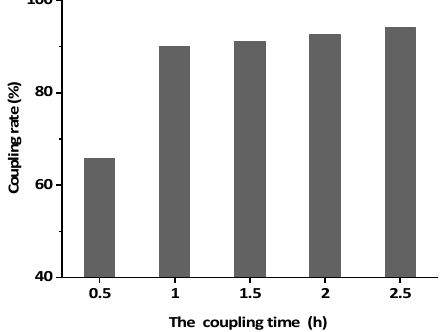
Figure 6. The coupling rate of different coupling times.